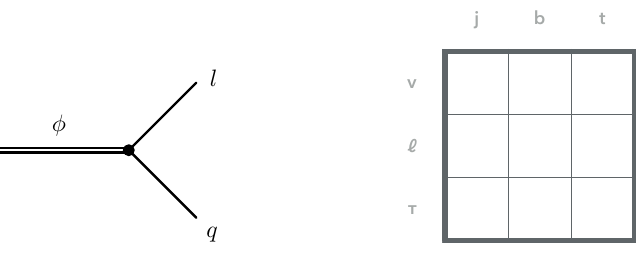
Figure 1 . ( Left ) LQ coupling to quark q and lepton l (see appendix A for notations used in the paper). ( Right ) LQ matrix. Each entry of the matrix represents one of the experimentally distinguishable leptoquark decays. Rows label leptonic decay products, columns label hadronic decay products. A more precise de(cid:12)nition of the LQ matrix is given in the text. For a summary of existing LHC searches corresponding to each matrix element see section